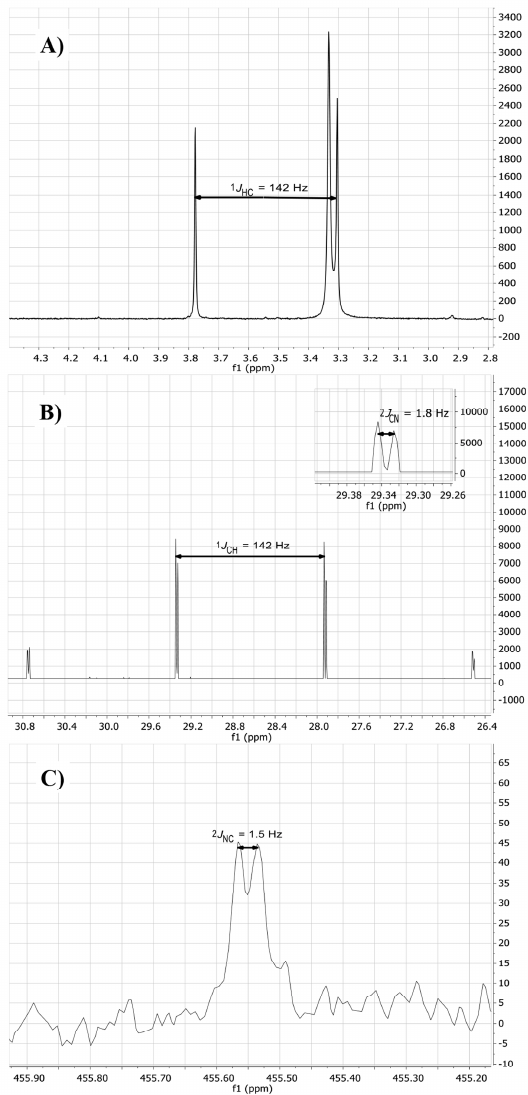
Figure 3. ( A ) 1 H-NMR spectrum of 13 C and 15 N labelled ZSM02 ( 9a ) in non-dry DMSO- d 6